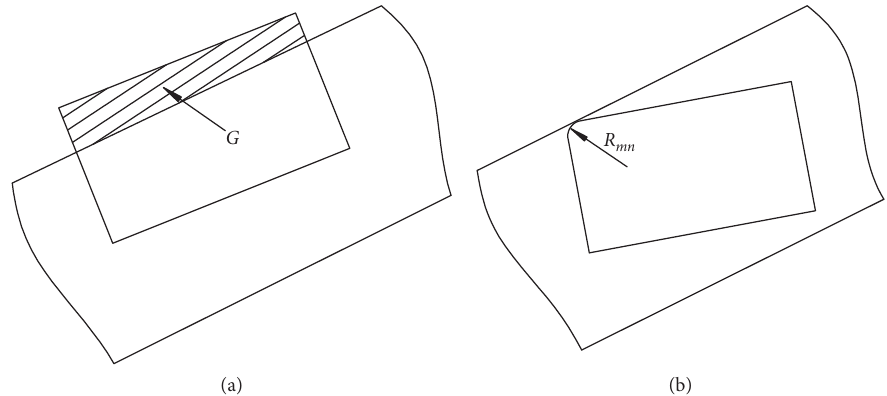
Figure 4: Contact mode between slider and guide. (a) Contact between two plane surfaces. (b) Contact between a plane and a spherical